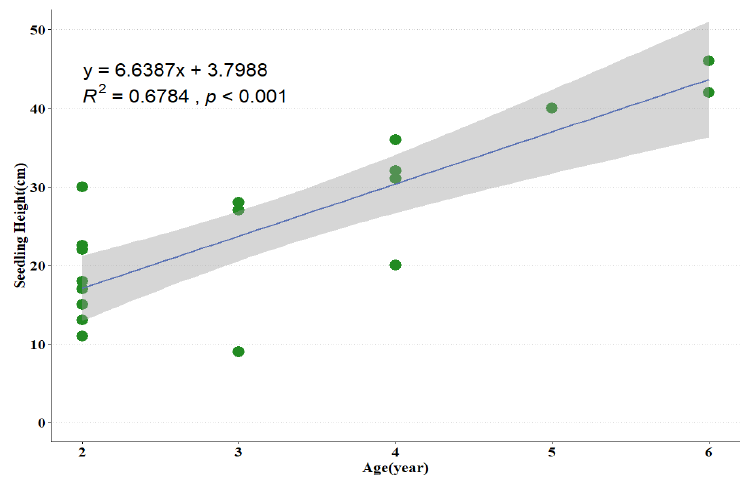
Figure 2. Linear regression between seedling height and age of Quercus acutissima seedlings.